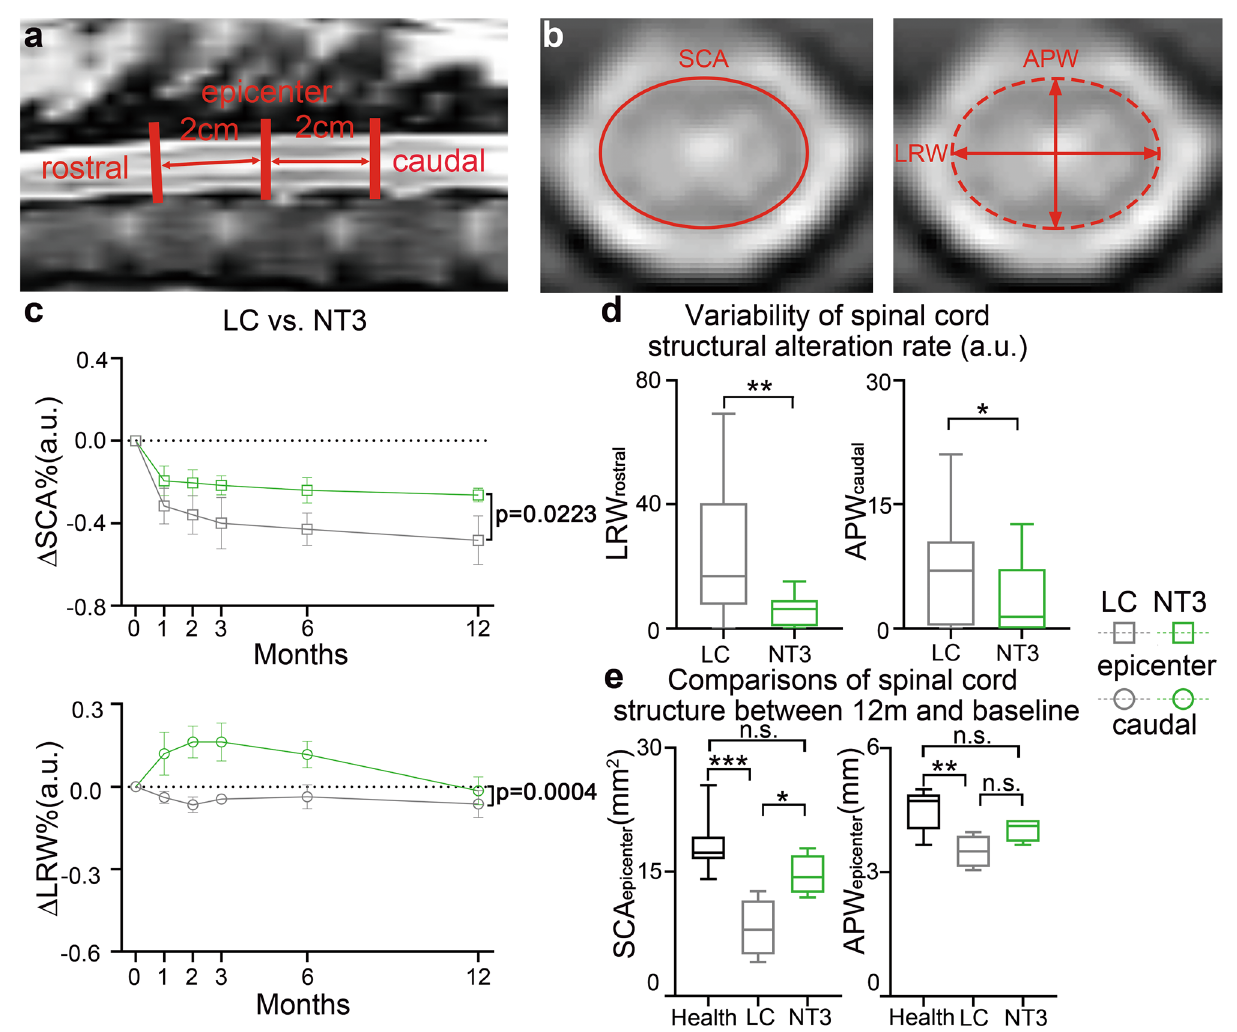
Figure 3. Differences in longitudinal SC structural alterations between LC and NT3 animals within 1 year post-SCI. ( a ) A schematic diagram of measurement of spinal cord structural parameters at the epicenter, 2 cm at the rostral, and 2 cm at the caudal of injury area. ( b ) The schematic diagram of measurement of SCA, LRW, and APW. ( c ) Differences in the longitudinal spinal cord structural alteration tendencies between LC (gray) and NT3 animals (green) (Chow breakpoint test). To avoid individual heterogeneity, the spinal cord structural parameters were divided by the corresponding individual baseline values to obtain the comparable normalized results. ( d ) Inter-group differences in the variability of spinal cord structural alterations (two-sample K-S Z test). ( e ) Differences in the spinal cord structural parameters between 12 m and baseline (one-way ANOVA with Bonferroni correction). Only parameters with significant difference were presented. *p < 0.05; **p < 0.01; ***p < 0.001; m represented the month; LC lesion control, NT3 neurotrophin-3, SCA spinal cord area, LRW left– right width, APW anterior–posterior